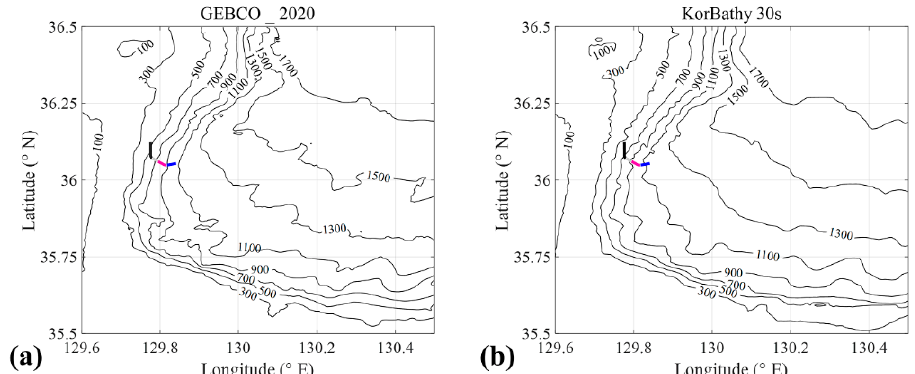
Figure 14. Bathymetry contour in the experimental site plotted using ( a ) the GEBCO 2020 and ( b ) the KorBathy 30s. The thick solid lines represent the route of the R/V vessel corresponding to ping 1~163 and the unit of the contour labels is meters.